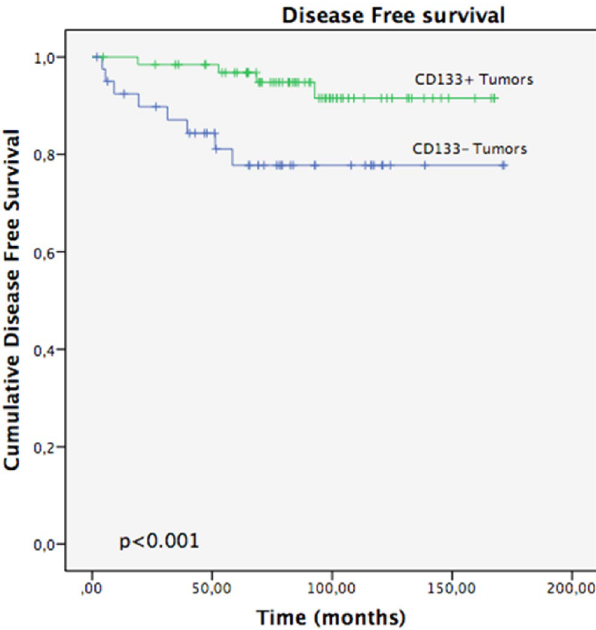
Figure 4. Progression Free Survival: CD133 + vs CD133 −